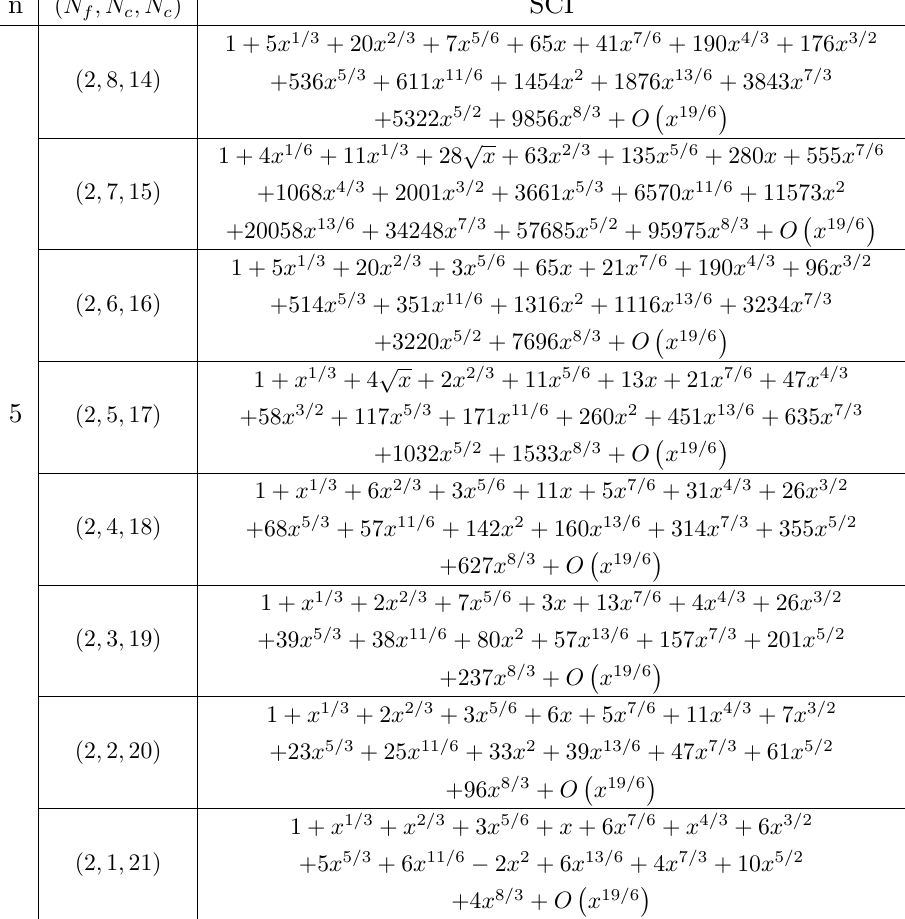
Table 15 . The superconformal index results for the double adjoint theories with ∆ W A = W + Here we list the cases with ( n, N ) = (3 , 1) , (3 , 2) and ( n, N f invariant operators with negative conformal dimension are flipped for the expansion of the index. The SU( N ) SU( N ) flavor fugacities are all omitted for simplicity. f t × f u